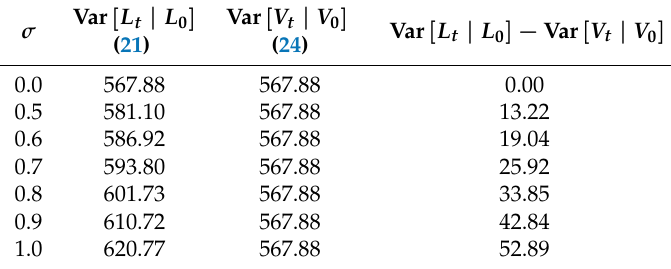
Table 3. The variance of loss: Var [ L t | L 0 ] .